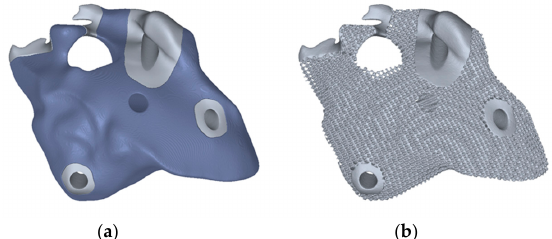
Figure 7. Another example shows the use of porous structures within an implant geometry. ( a ) The definition of the design space for the lattice structure (dark blue); ( b ) The final implant design.